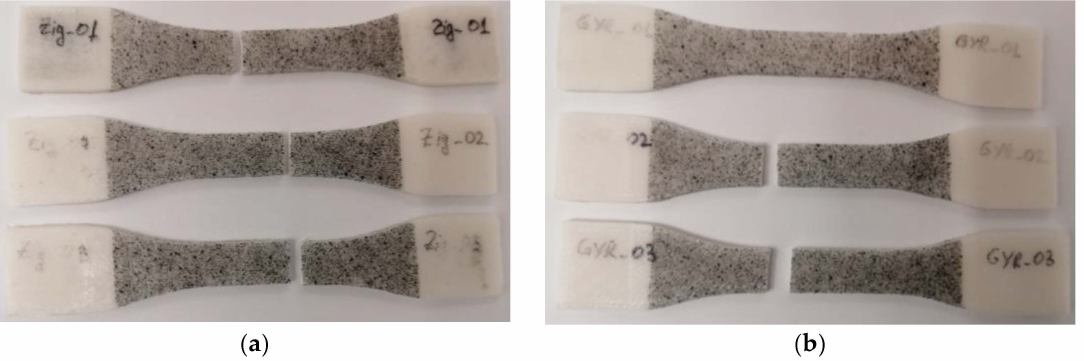
Figure 10. Failure patterns of the 3D-printed PCL: zig-zag tensile specimens ( a ); gyroid tensile specimens ( b ).